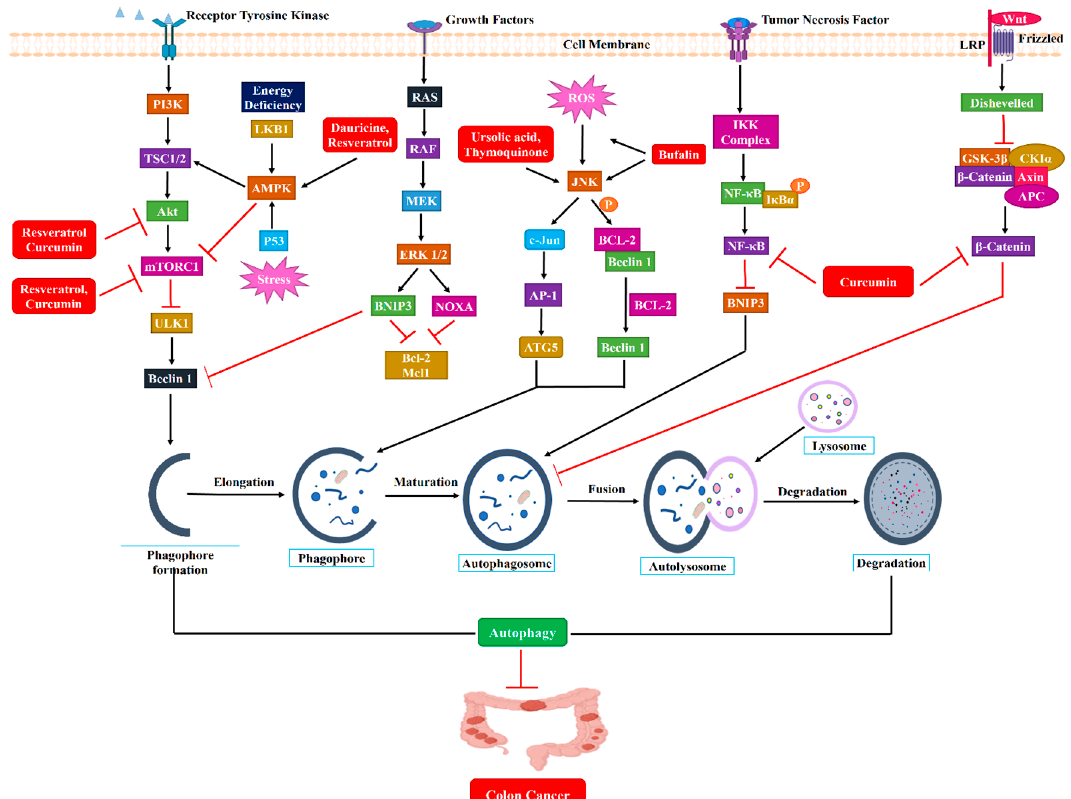
Figure 3. The relationship between the natural products targeting the major signaling pathways that modulate autophagy and colon cancer. Regulation of autophagy induction by the Unc-51-like kinase 1 (ULK1) complex is mediated by the PI3K/AKT pathway. mTOR is negatively regulated by LKB1/AMPK, while cytoplasmic p53 stimulates mTOR by blocking AMPK. Autophagy is also activated by the RAS/RAF/ERK pathway via Beclin-1 to facilitate nucleation. Expression of Atg5 regulates phagophore development, which is induced by reactive oxygen species, leads to the activation of c-Jun NH2-terminal kinases (JNKs). Bufalin could induce oxidative stress by activating JNK. JNK has the ability to phosphorylate Bcl-2 and liberate Beclin 1, thereby promoting autophagy. Alternately, JNK can stimulate the phosphorylation of c-jun; which promotes the generation of AP-1 that enhances the expression of numerous genes, including Beclin 1, Atg5, and Atg7. Beclin 1 and Atg 5 have the potential to induce autophagy. In contrast, the Wnt/ β -catenin pathway activates and recruits β -catenin protein into the nucleus, thereby directly regulating autophagy. Without Wnt, a destruction complex degrades β -catenin in the canonical Wnt pathway, preventing cytoplasmic accumulation. The following proteins comprise this destruction complex: Axin, glycogen synthase kinase 3 β (GSK3 β ), adenomatosis polyposis coli (APC), and casein kinase 1 α (CK1 α ). On the other hand, Beclin 1 and some other autophagy-linked protein expression levels are increased by the IKK α / β and NF- κ B pathways, inducing autophagy. In addition, NF- κ B signaling can inhibit autophagy by overexpressing autophagy repressors such as Bcl-2/Xl and BNIP3. Natural products targeting the key signaling pathways that control autophagy in colon cancer. T-arrows represent inhibition, whereas arrows represent